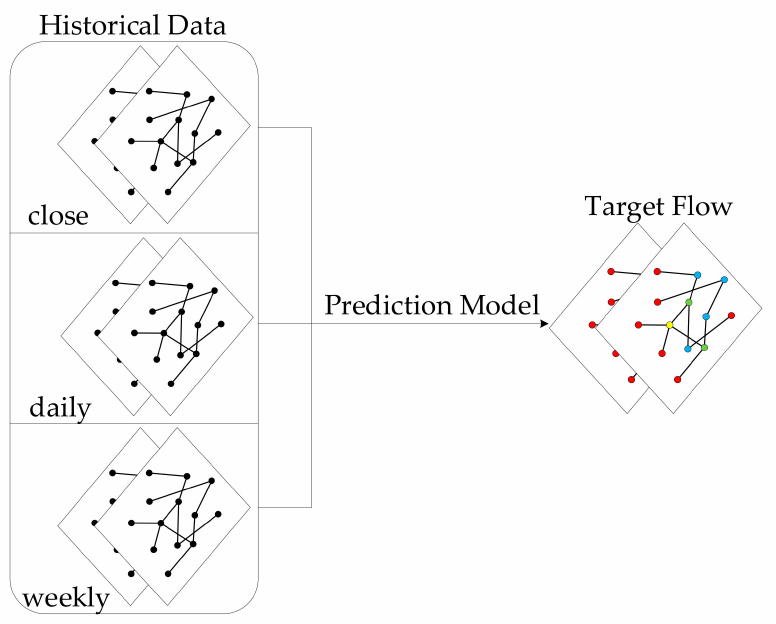
Figure 1. Schematic diagram of the prediction